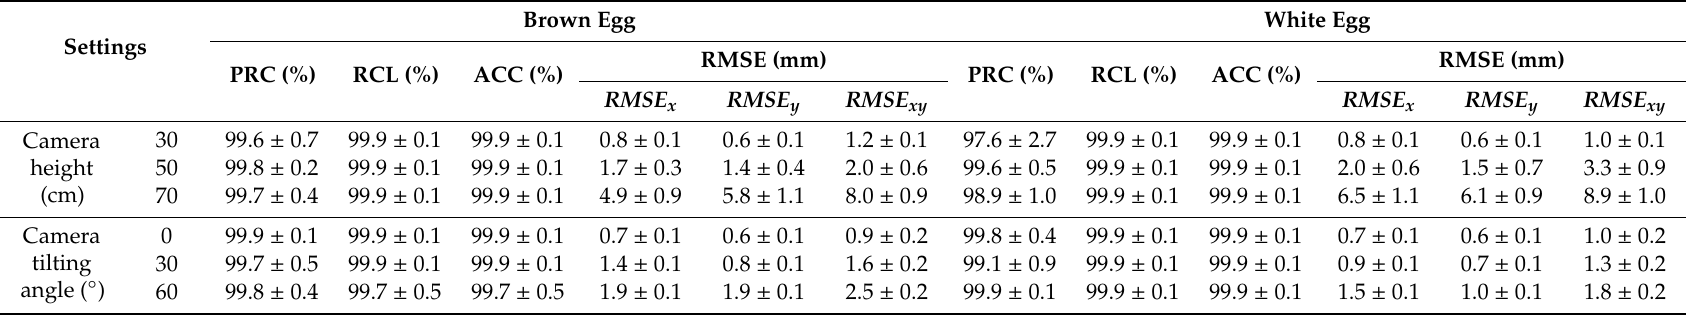
Table 4. Performance (mean ± standard deviation) of the faster region-based convolutional neural network (faster R-CNN) floor-egg detector on floor egg detection under di ff erent camera settings using average 40 images of each level of the settings in each of the five events. Brown Egg White Egg Settings